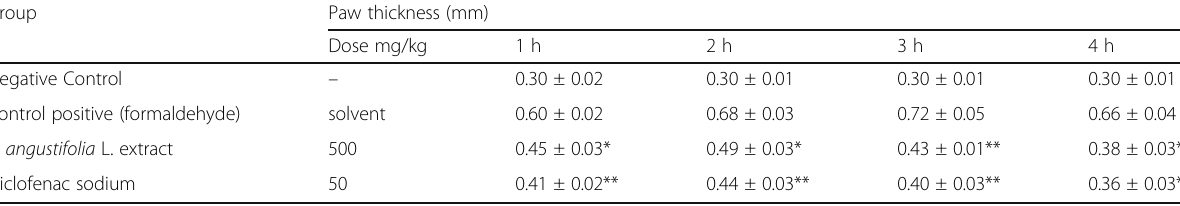
Table 2 Formaldehyde induced paw edema measured as paw thickness in rats treated with P. angustifolia L. extract and in control rats (n = 5) Group